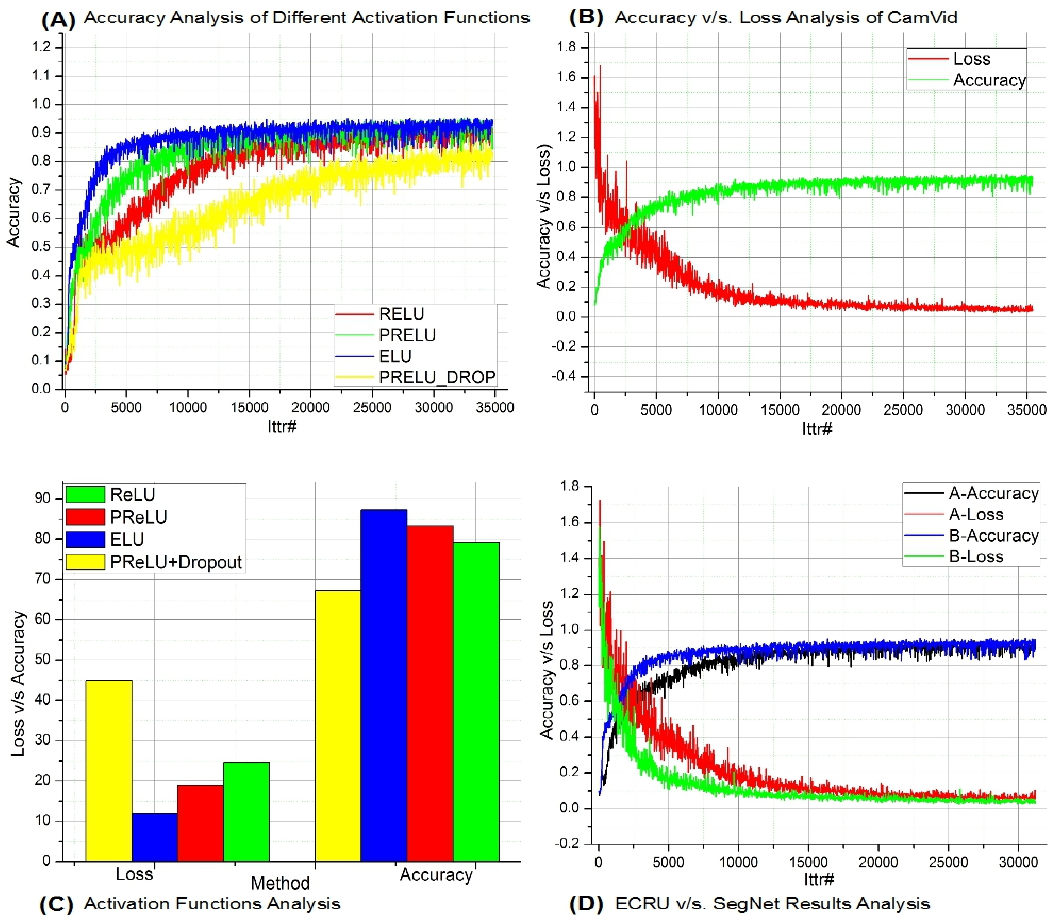
Figure 4. ECRU experiments